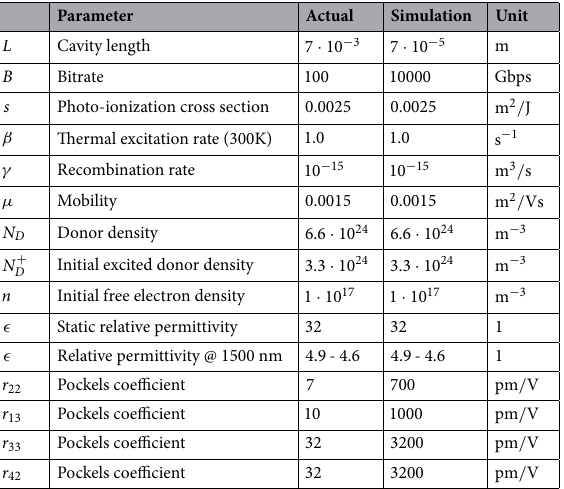
Table 1. Simulation parameters for the LiNbO 3 crystal simulated with FDTD. Each of the actual values 29–31 is followed by the values used in simulation. The values used in simulation are chosen to partly compensate for the reduced cavity size that can be simulated with an FDTD simulator.